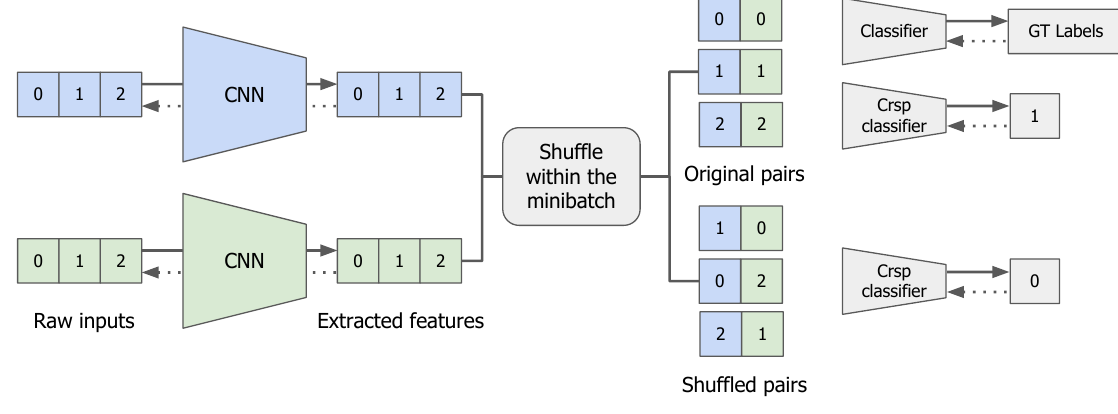
Figure 1. Overall architecture of the proposed correspondence learning approach. In the figure, two different modalities are shown in two colors (blue/green), and three samples are given for training. The overall architecture consists of three parts: a feature extractor, classifier and correspondence classifier. The training process consists of two parts: (1) each modality input in each sample is given to the modality-specific feature extractor (written as CNN), (2) multi-modal features are concatenated and trained with the ground-truth labels and are used as positive correspondence samples ( top ), while shuffled samples are used as the negative correspondence pairs ( bottom ). Note that there are two losses used: the cross-entropy loss for classification, and the binary cross-entropy loss for correspondence